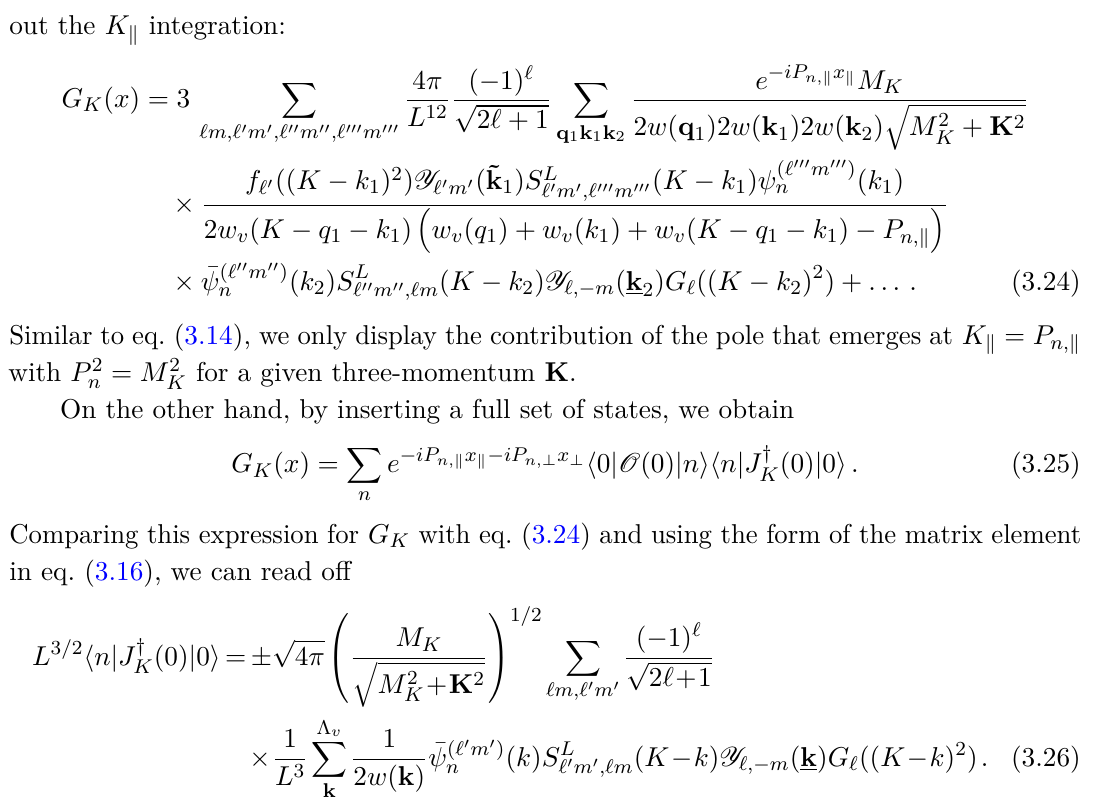
( x ) and the two-point function K